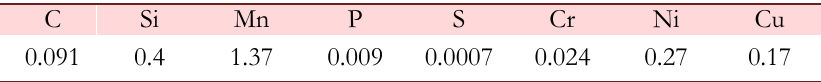
Table 1: Chemical composition of the C-Mn